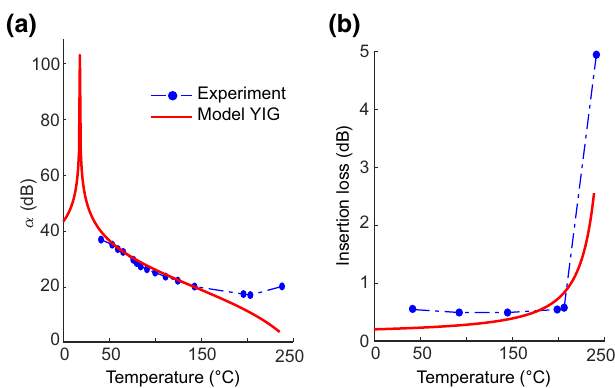
FIG. 10. Comparison of experimental results for ISO PM 2 and the model for YIG with θ = 44.43 ◦ for (a) the isolation coefficient and (b) insertion